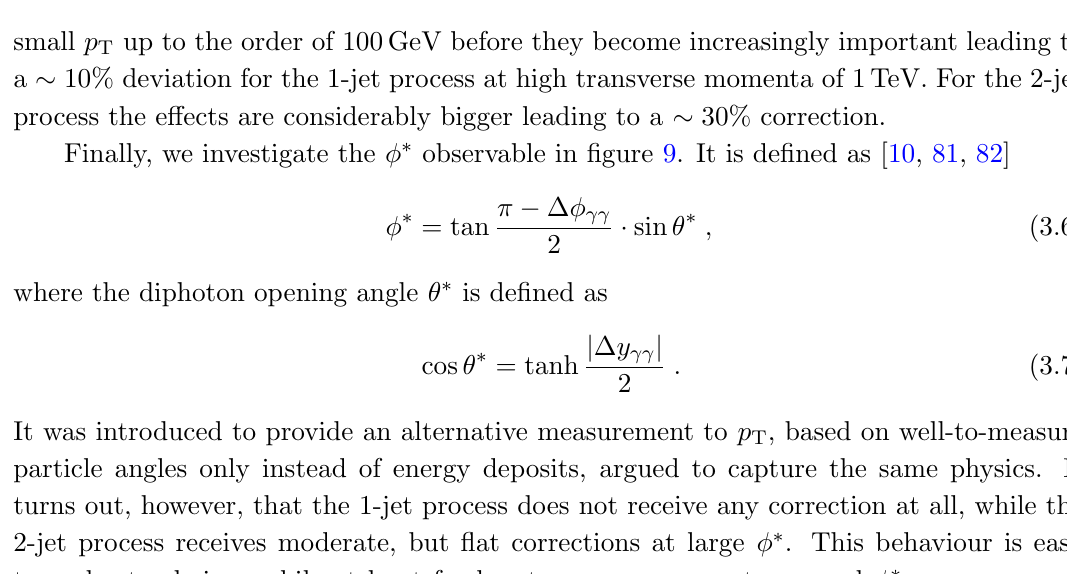
Figure 7 . Azimuthal separation of the leading and subleading isolated photon system in (cid:13)(cid:13) + 1 ; 2 jets production at 13 TeV at the